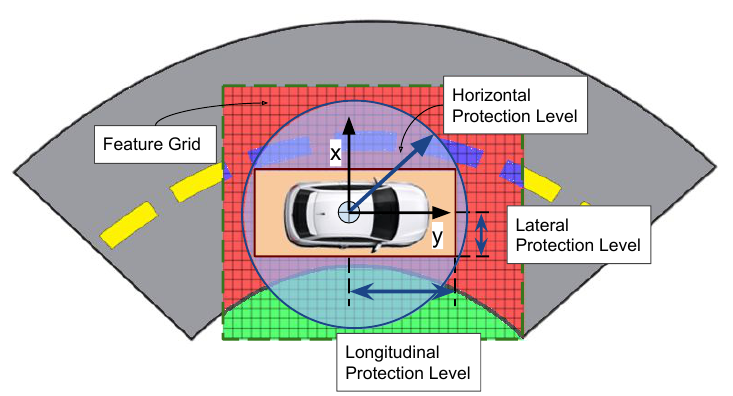
Figure 8. Illustration of protection levels for the localization of ground